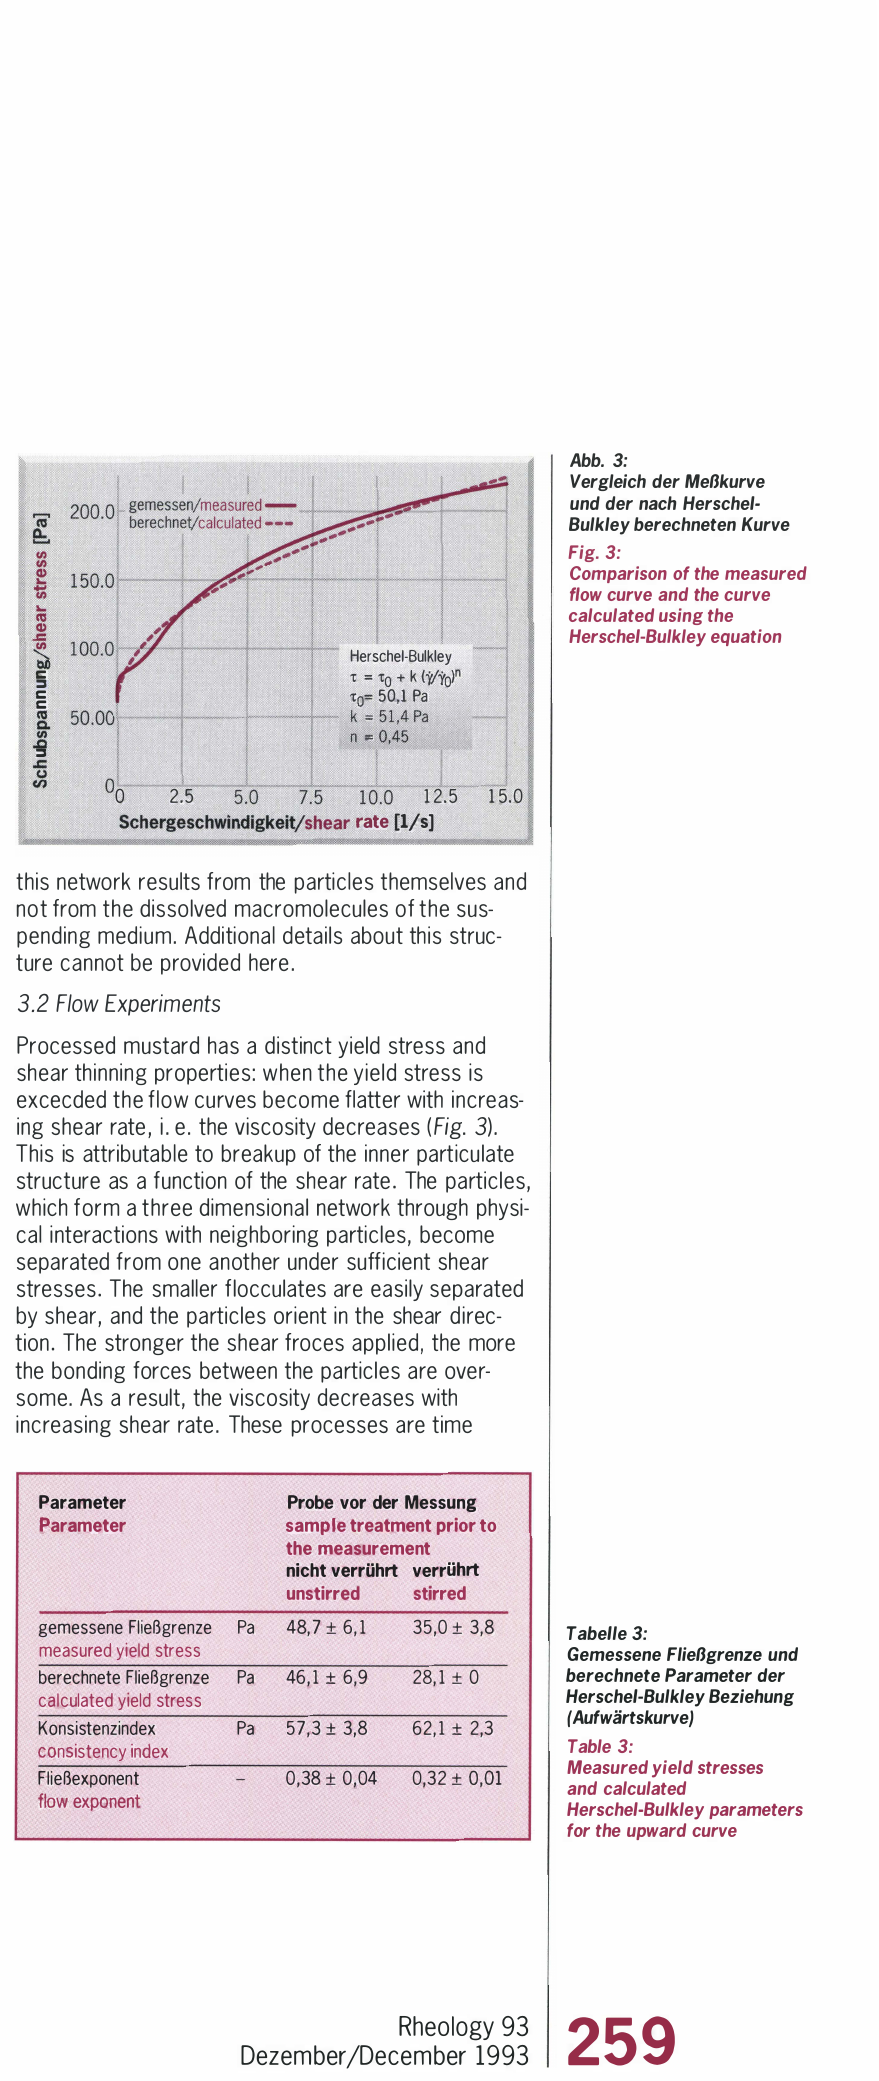
Tabe/le 3: Gemessene Flie/Jgrenze und berechnete Parameter der Herschei-Bulkley Beziehung (Aufwiirtskurve} Table 3: Measured yield